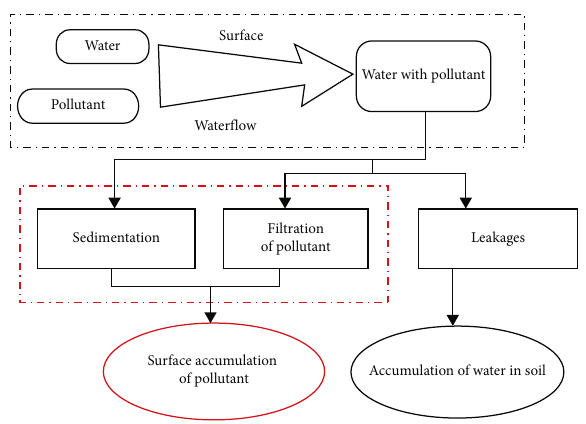
Figure 1: Scheme of pollutant propagation in water reservoir from point source (adopted from